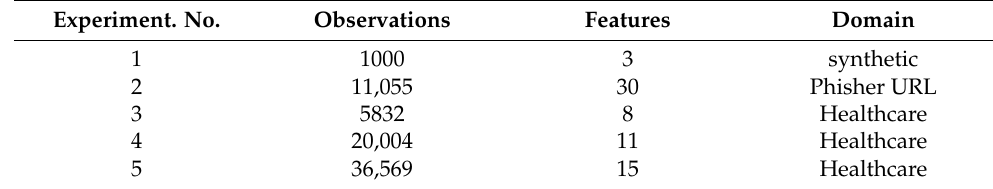
Table 2. The dataset description of the experiments. Experiment. No.